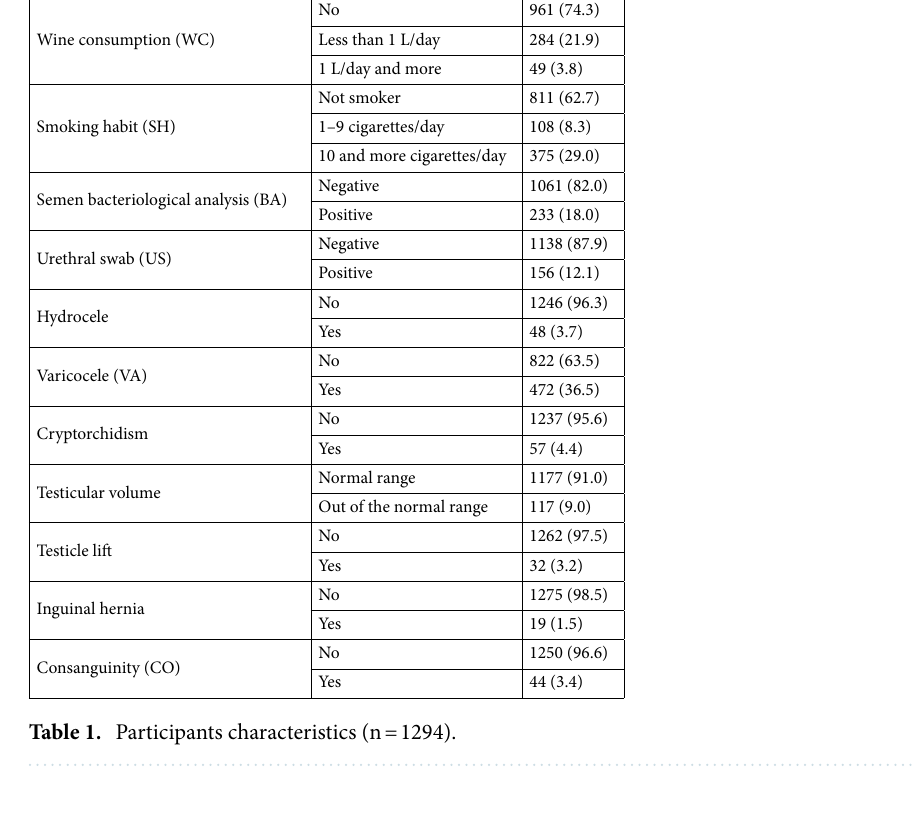
Semen parameters